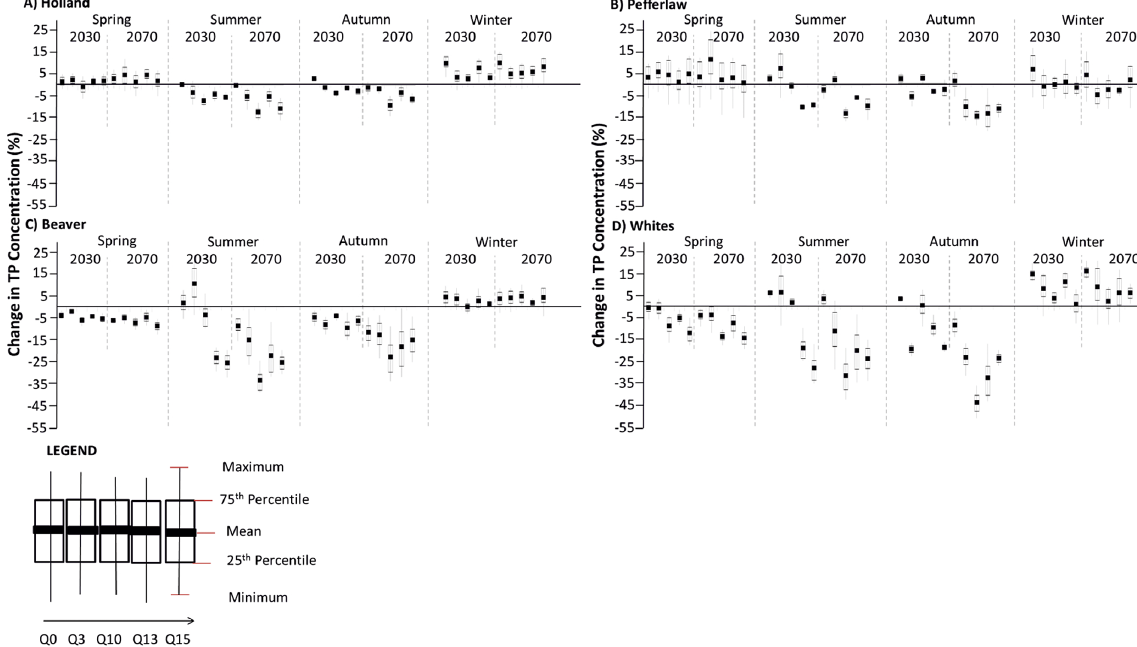
Figure 12. Box plot of seasonal changes in total phosphorus concentrations across all perturbed physics ensemble members (one box per ensemble member) in (a) Holland, (b) Pefferlaw, (c) Beaver and (d)